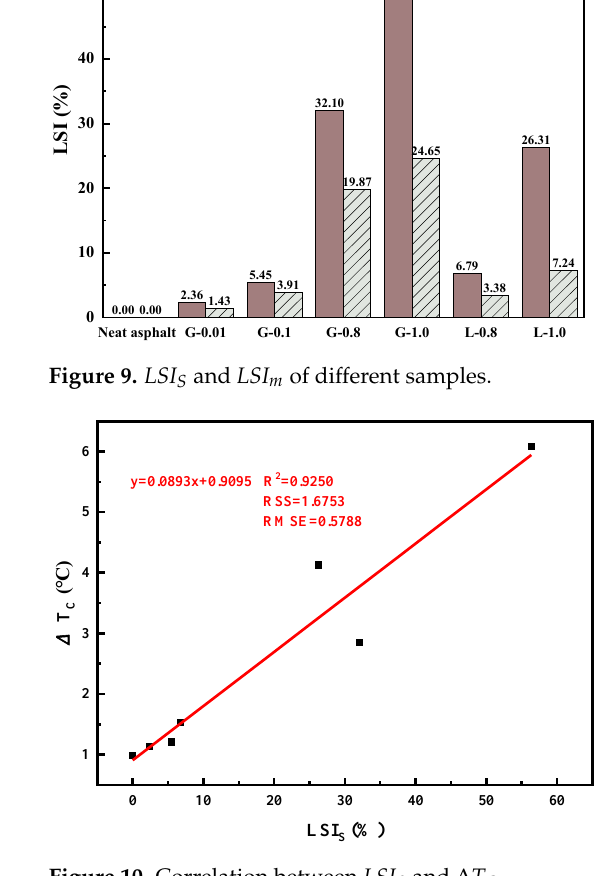
Figure 10. Correlation between LSI S and Δ T C